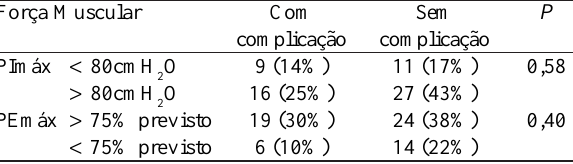
Tabela 3. Relação entre PImáx, PEmáx e as complicações